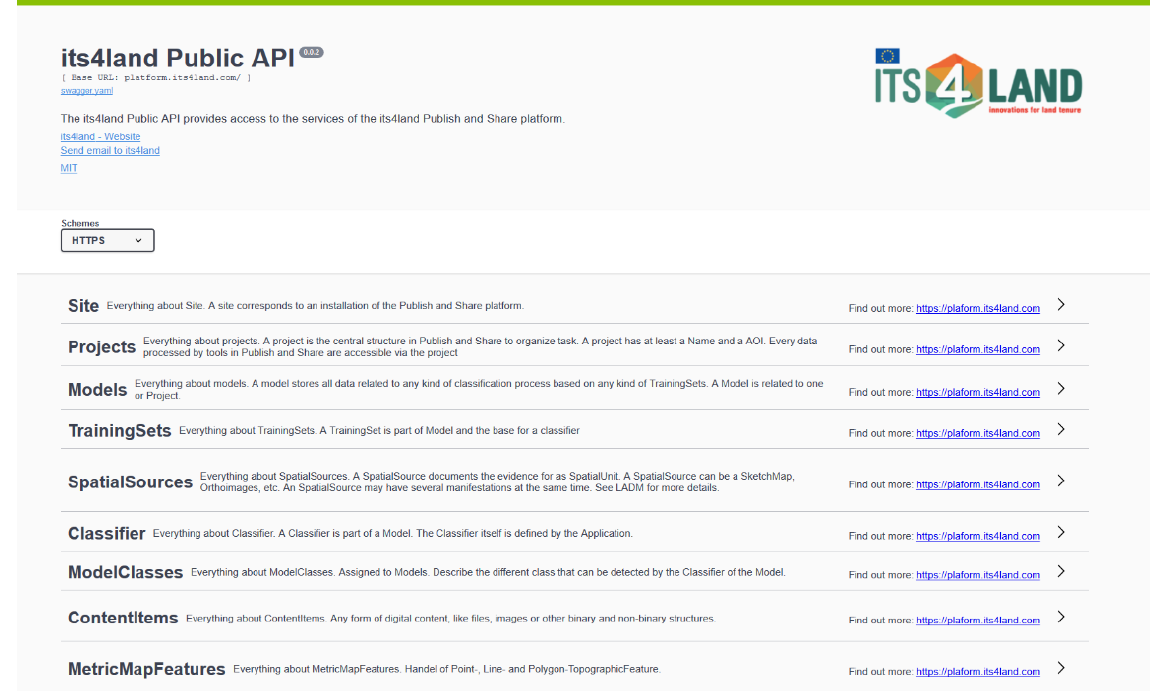
Figure 2. The main user interface of the online documentation of the Public API.